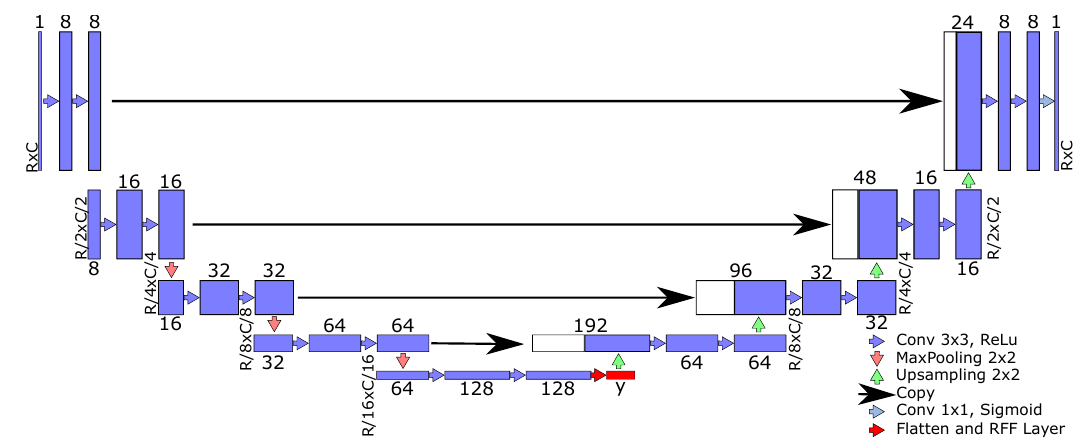
Figure 2. RFF-U-net architecture for semantic segmentation. U-shaped network to preserve both low and high-level features using an encoder–decoder approach. The RFF layer is located at the bottleneck (red block). The number of filters, kernel size, stride, and nonlinear activation function are